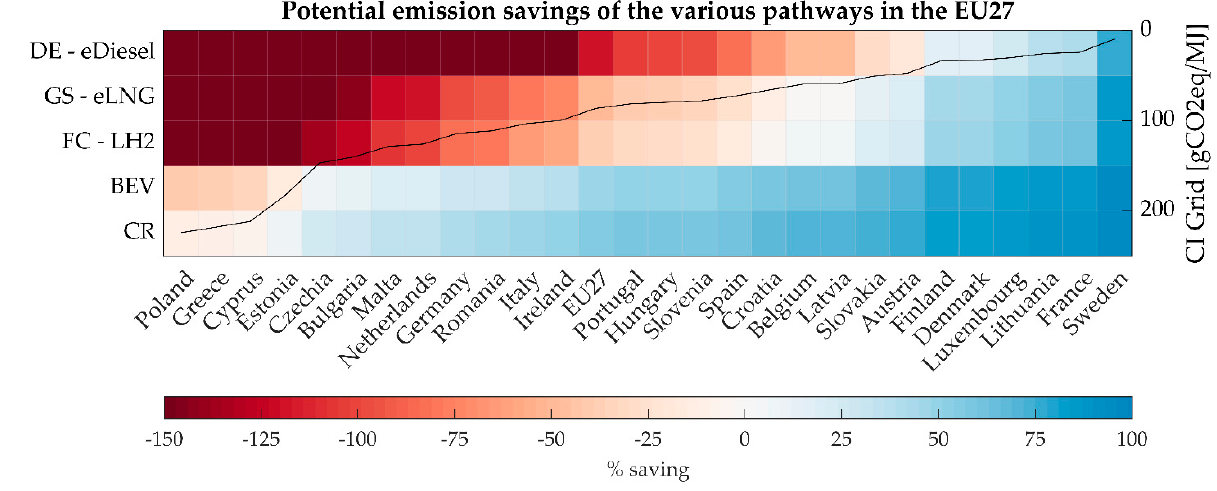
Figure 4. WTW results for the investigated e-fuels-powered powertrain options.